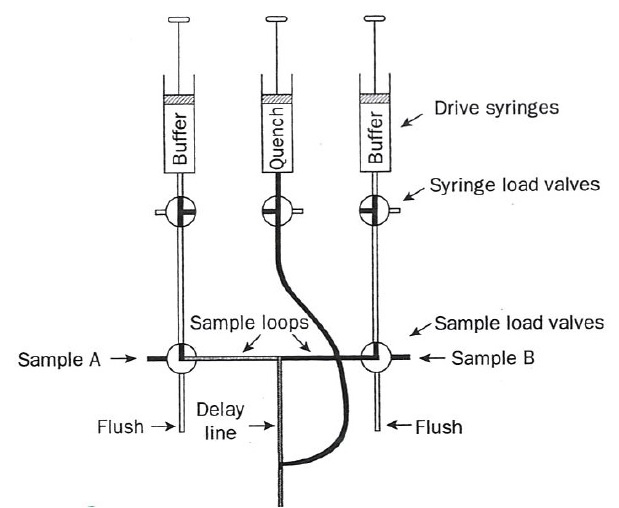
Figure 2. Diagram of a flow quench apparatus used in kinetic measurements. The figure was adapted from one available on p. 221